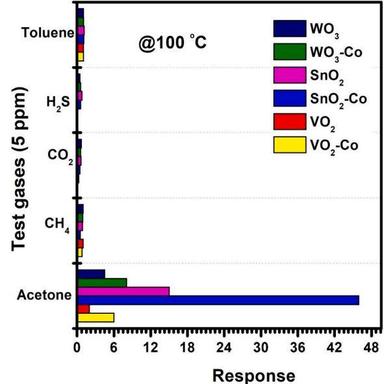
Gas response of WO3, WO3-Co, SnO2, SnO2-Co, VO2, and VO2-Cobased sensors towards 5 ppm of different test gases including acetone, methanol (CH4), Carbon dioxide (CO2), Hydrogen sulphide (H2S) and toluene concentrations. (For interpretation of the references to colour in this figure legend, the reader is referred to the web version of this article.)